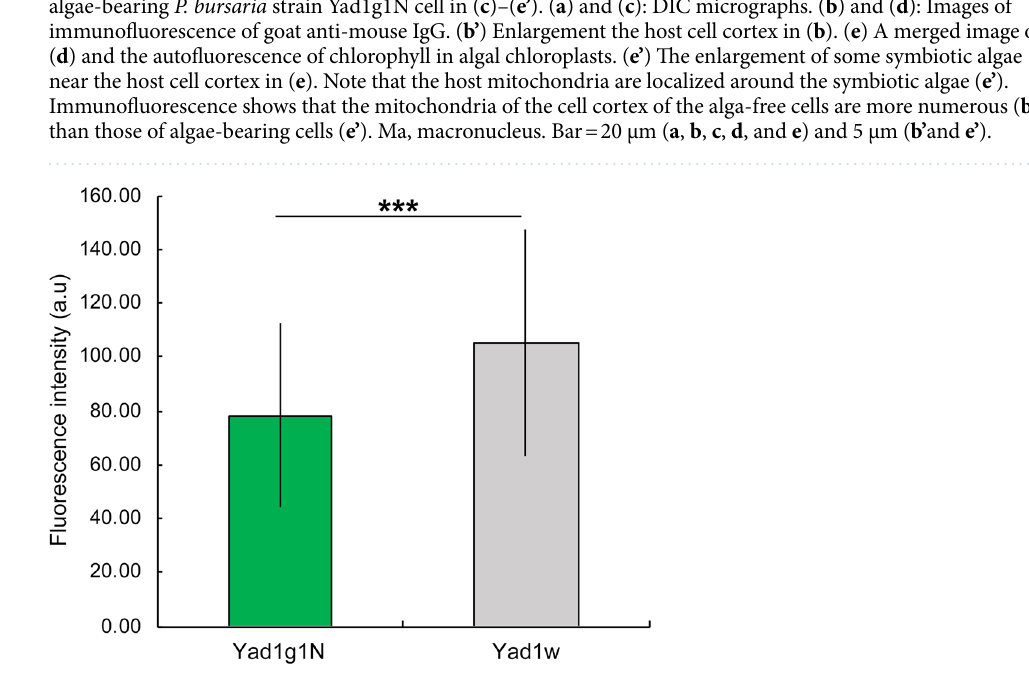
Figure 3. Immunofluorescence intensity of mitochondria of alga-free and algae-bearing P. bursaria cells. In alga-free P. bursaria cells (gray bar graph), the immunofluorescence intensity is greater than that of algae- bearing P. bursaria cells (green bar graph). Ten to twelve Paramecium cells were observed. Error bars show standard deviation (SD). Asterisks indicate significant differences (two-sided Fisher’s exact test, *** P <